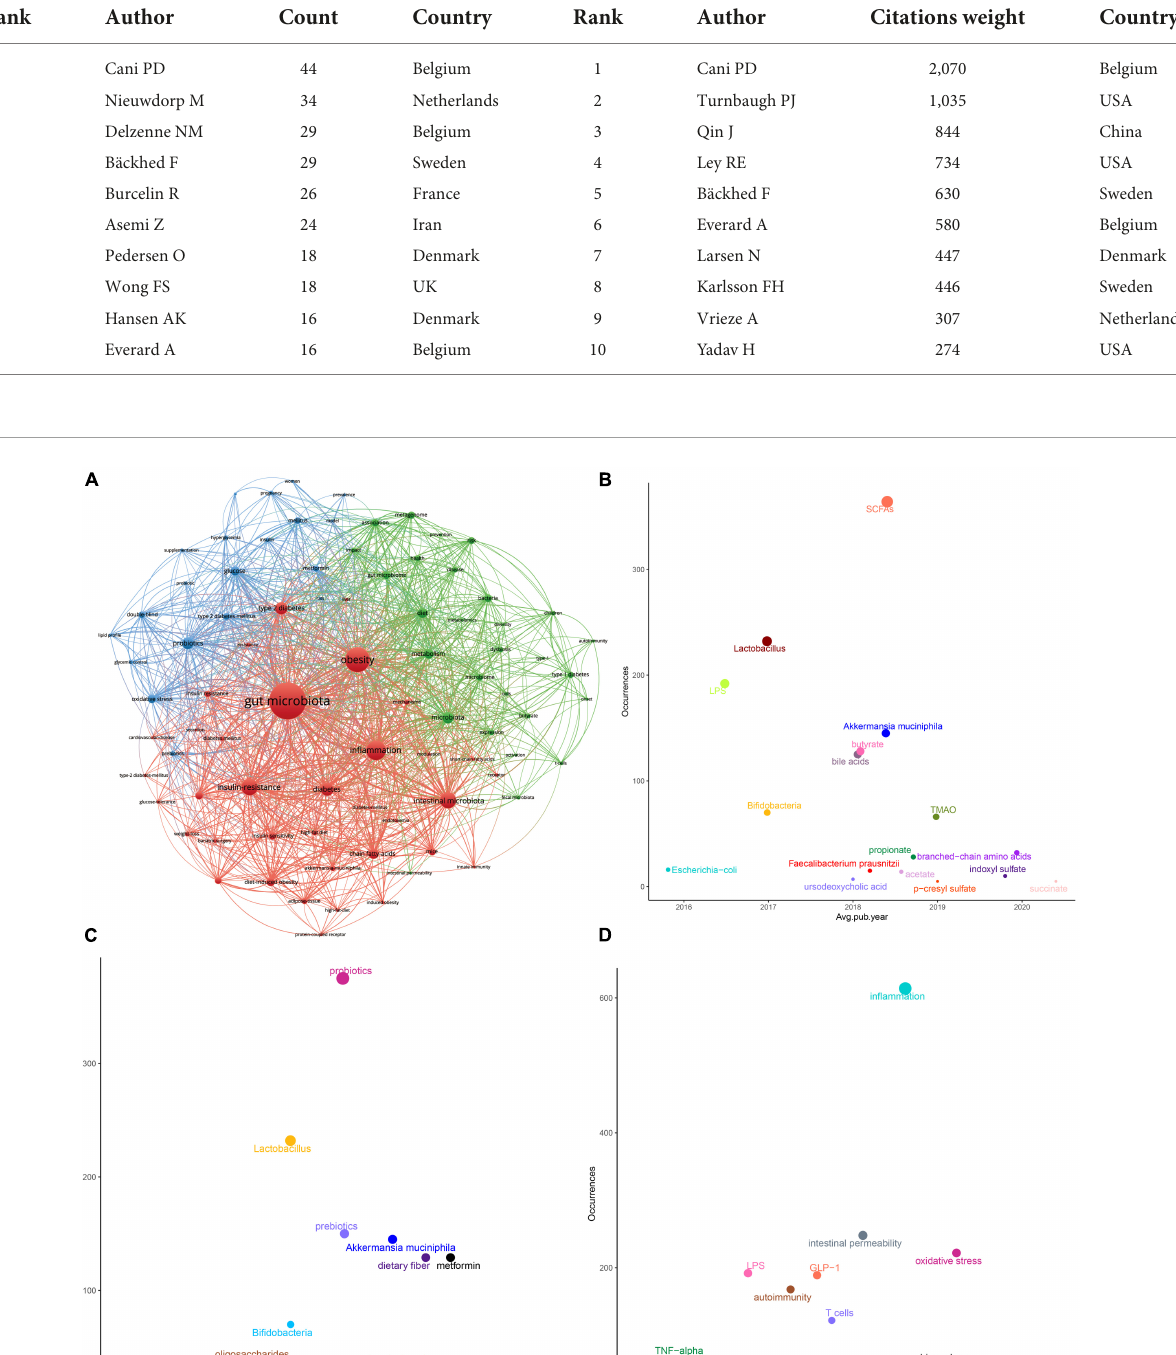
TABLE 5 Top 10 productive authors and co-cited authors in the “gut microbiota and diabetes” area.